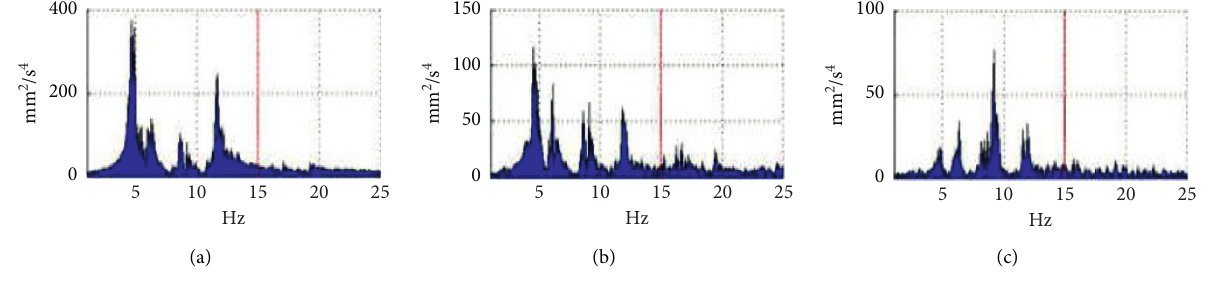
Figure 6: Vibration spectrum of spans under traffic